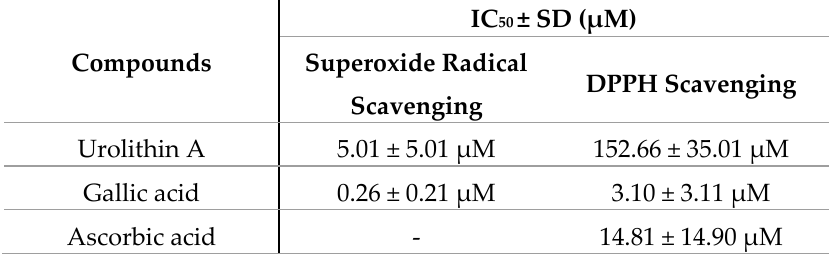
Figure 8. Antioxidant activity of urolithin A against physiological (superoxide) and synthetic (DPPH) radicals. IC 50 were calculated by non-linear regression. ( A ) Urolithin A scavenges superoxide radicals generated by the xanthine/xanthine oxidase system. ( B ) DPPH inhibition of urolithin A. Gallic acid and ascorbic acid were used as reference antioxidants.